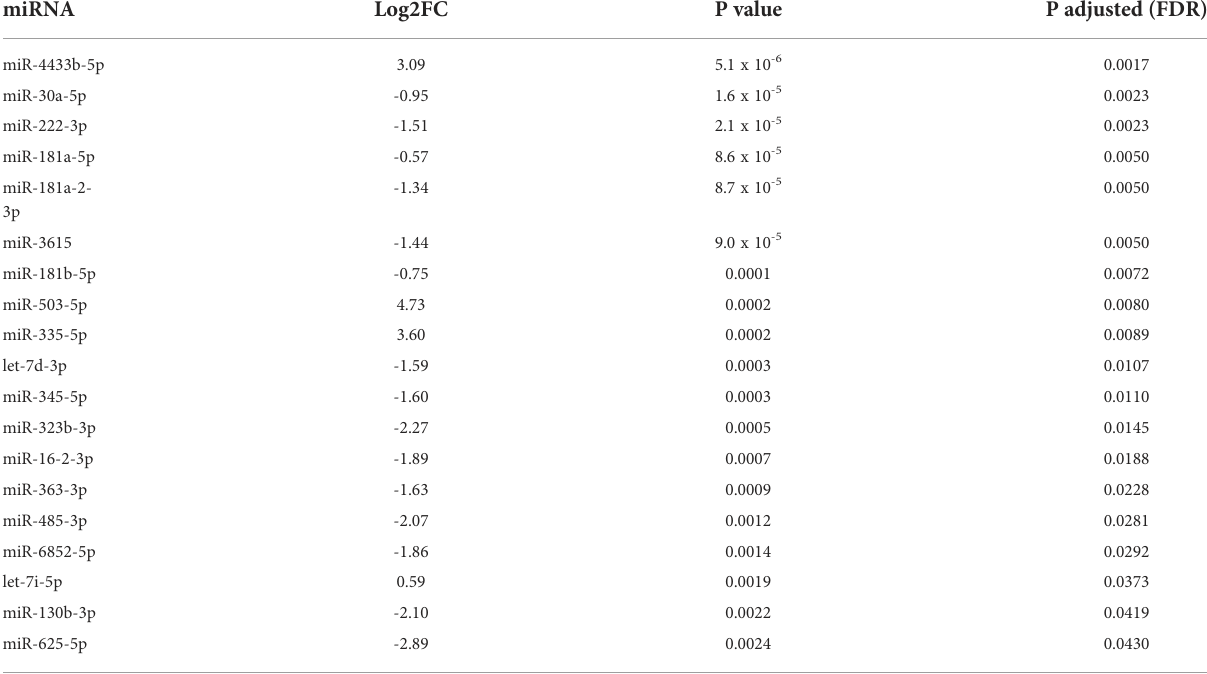
TABLE 2 Results of differential expression analysis between preoperative GH secreting PitNET patients ’ plasma vs. NF PitNET patients ’ plasma. miRNA